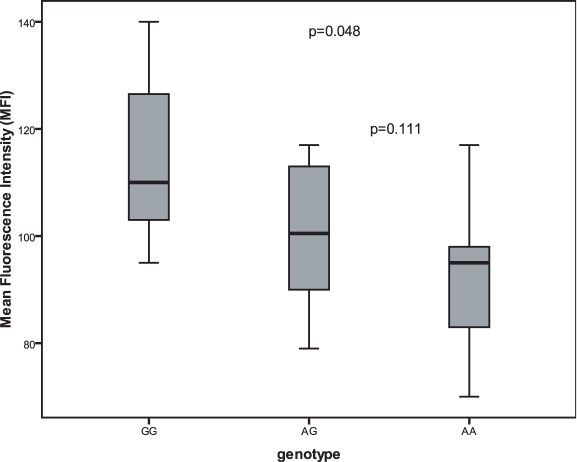
Expression of the FCER1 alpha chain on IgE-stripped basophils.PBMCs were isolated from individuals displaying high sIgE levels and FCER1 alpha chain expression was measured after stripping IgE from its receptor by lactic acid buffer incubation by FACS. Results are expressed as mean fluorescence intensity for FCER1A in the basophile gate. Significance was calculated using the Student's-t-test.